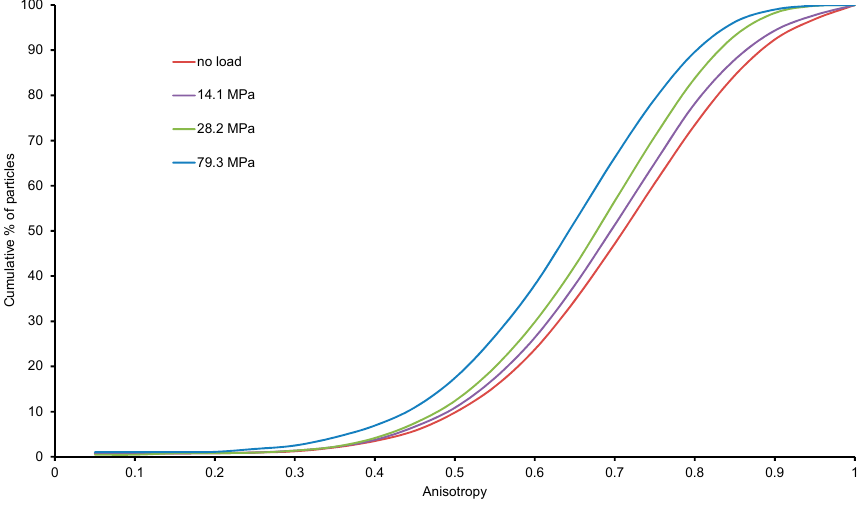
Figure 14. Anisotropy distributions of particles with vertical stresses.